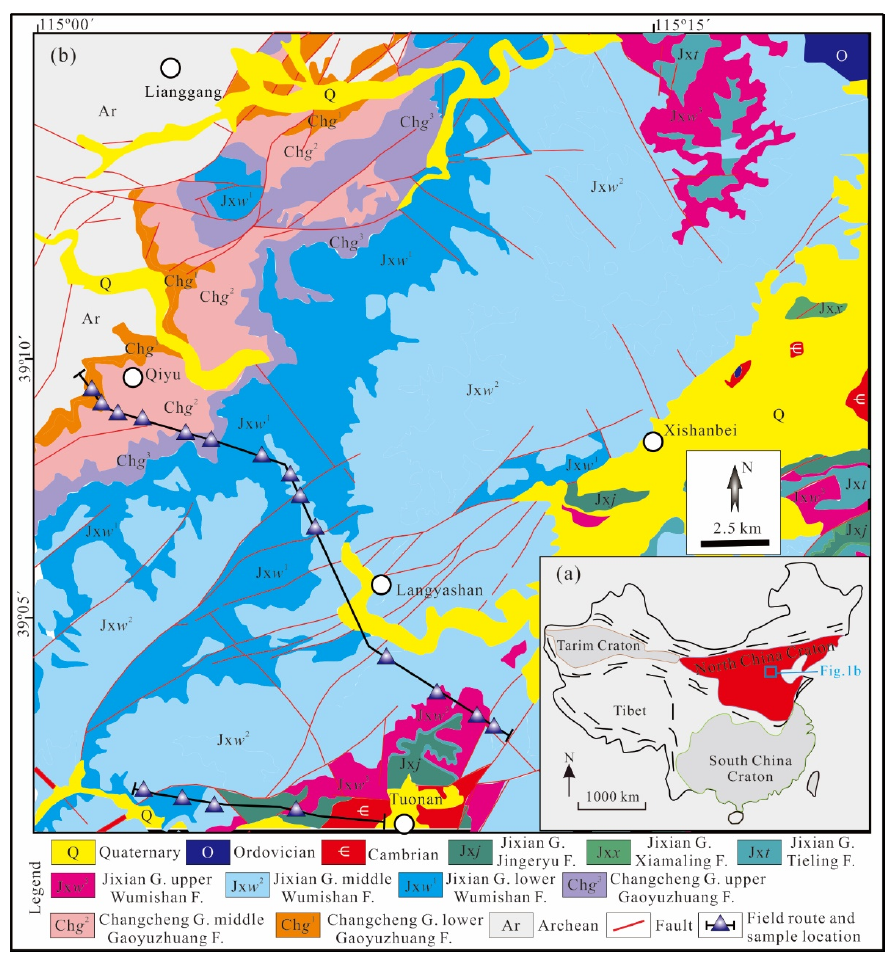
Figure 1. ( a ) Tectonic location of the study area in China. ( b ) Geologic map of the eastern North China Craton showing the main structures and strata.